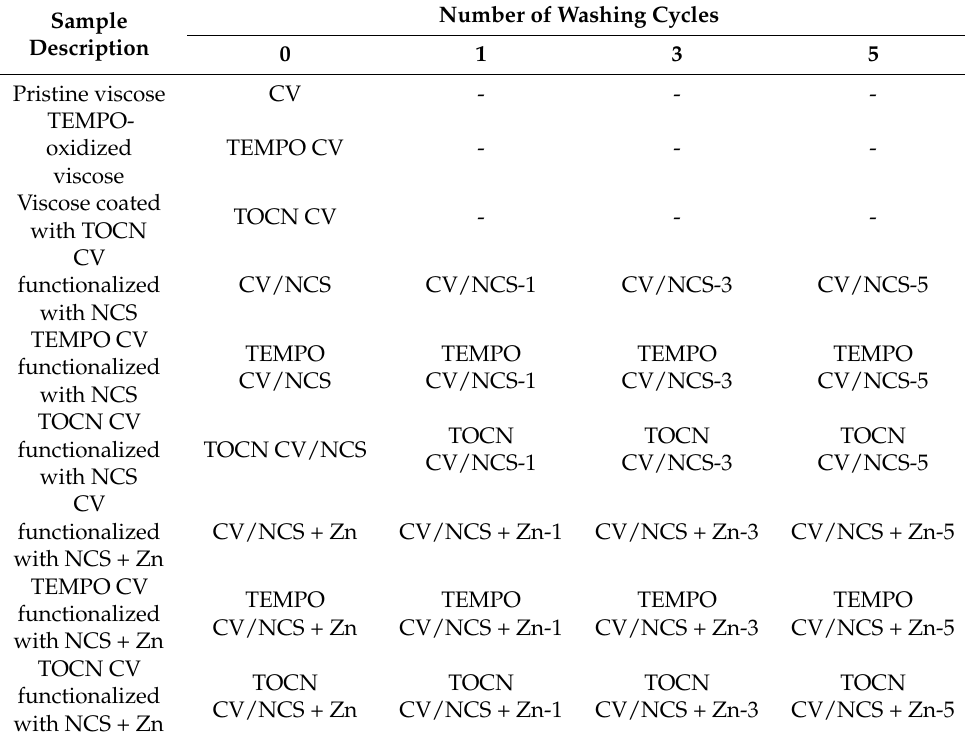
Table 1. Denotation of the viscose fabric samples before and after washing